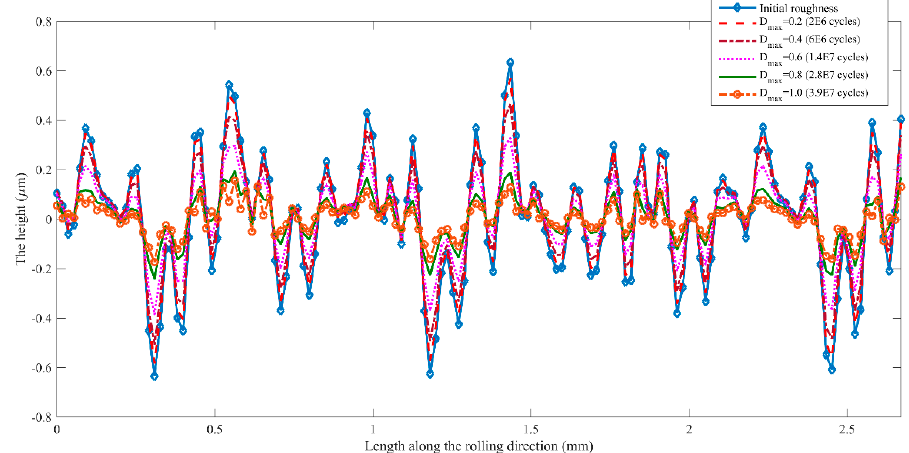
Figure 17. The surface roughness profile of different damage stage with the adjustment of the reference lines of the driven gear [104].